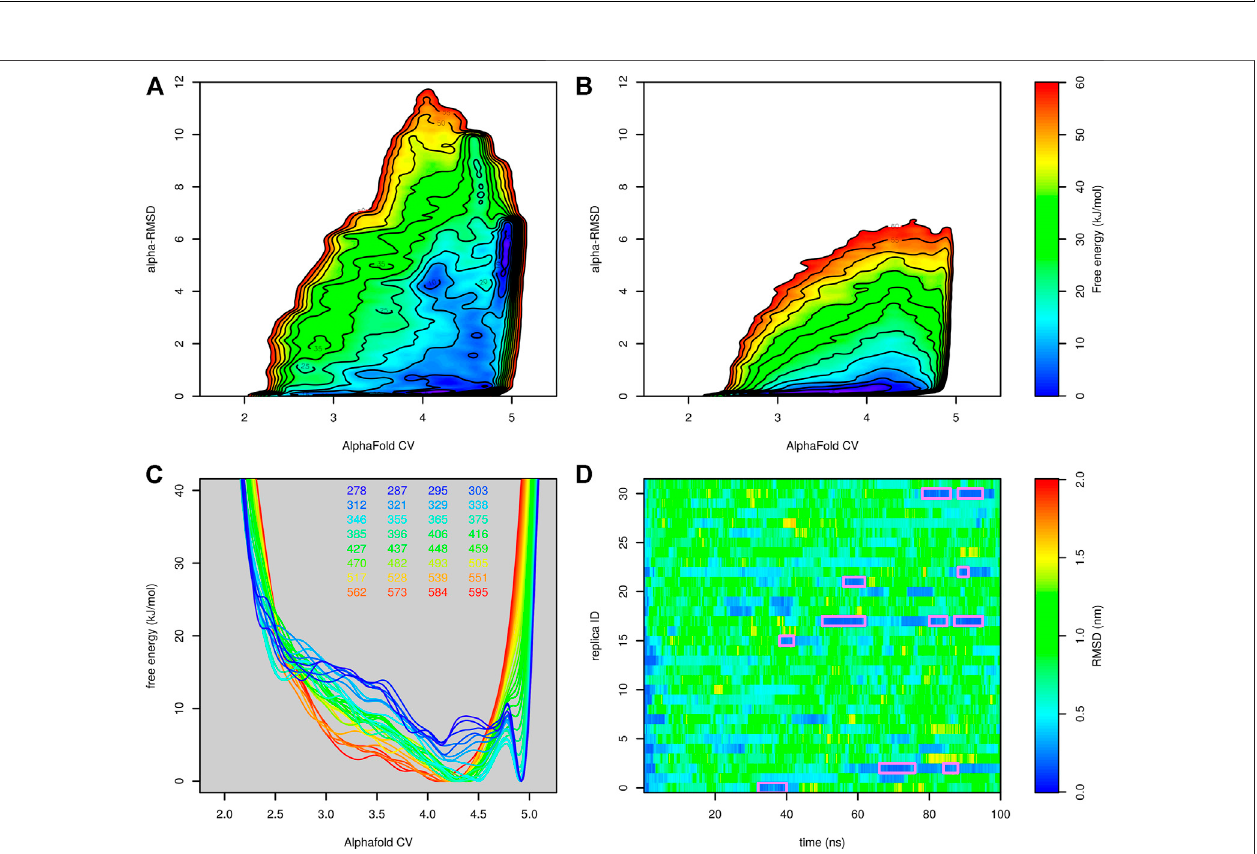
FIGURE6| ResultsofparalleltemperingmetadynamicssimulationofTrp-cagewithAlphaFold-basedCVand α -RMSDcollectivevariables. (A) Free-energysurface at 303 K, (B) free-energy surface at 595 K, (C) free-energy surfaces calculated at different temperatures and (D) pro fi les of RMSD as a function of time calculated for demultiplexed